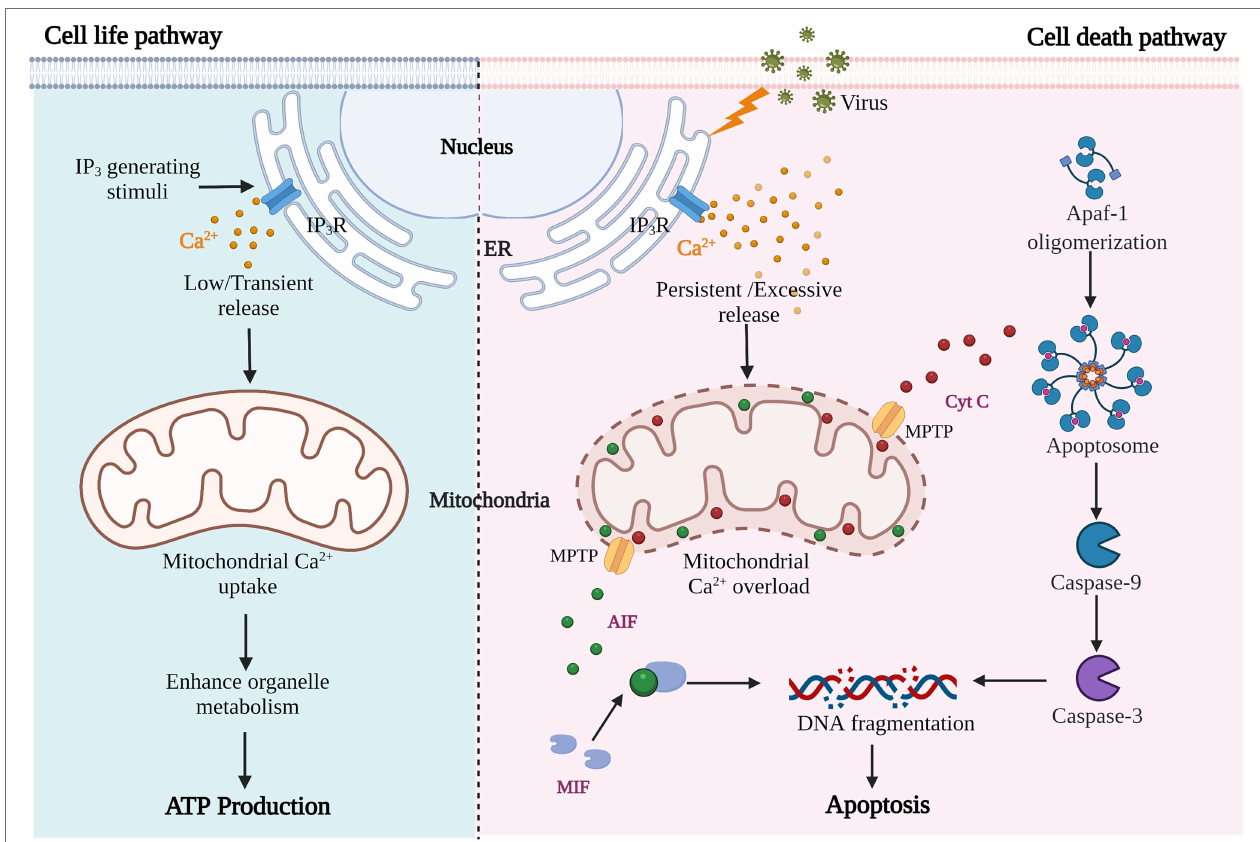
FIGURE 3 | Results of cell metabolism or apoptosis induced by different Ca 2+ -related